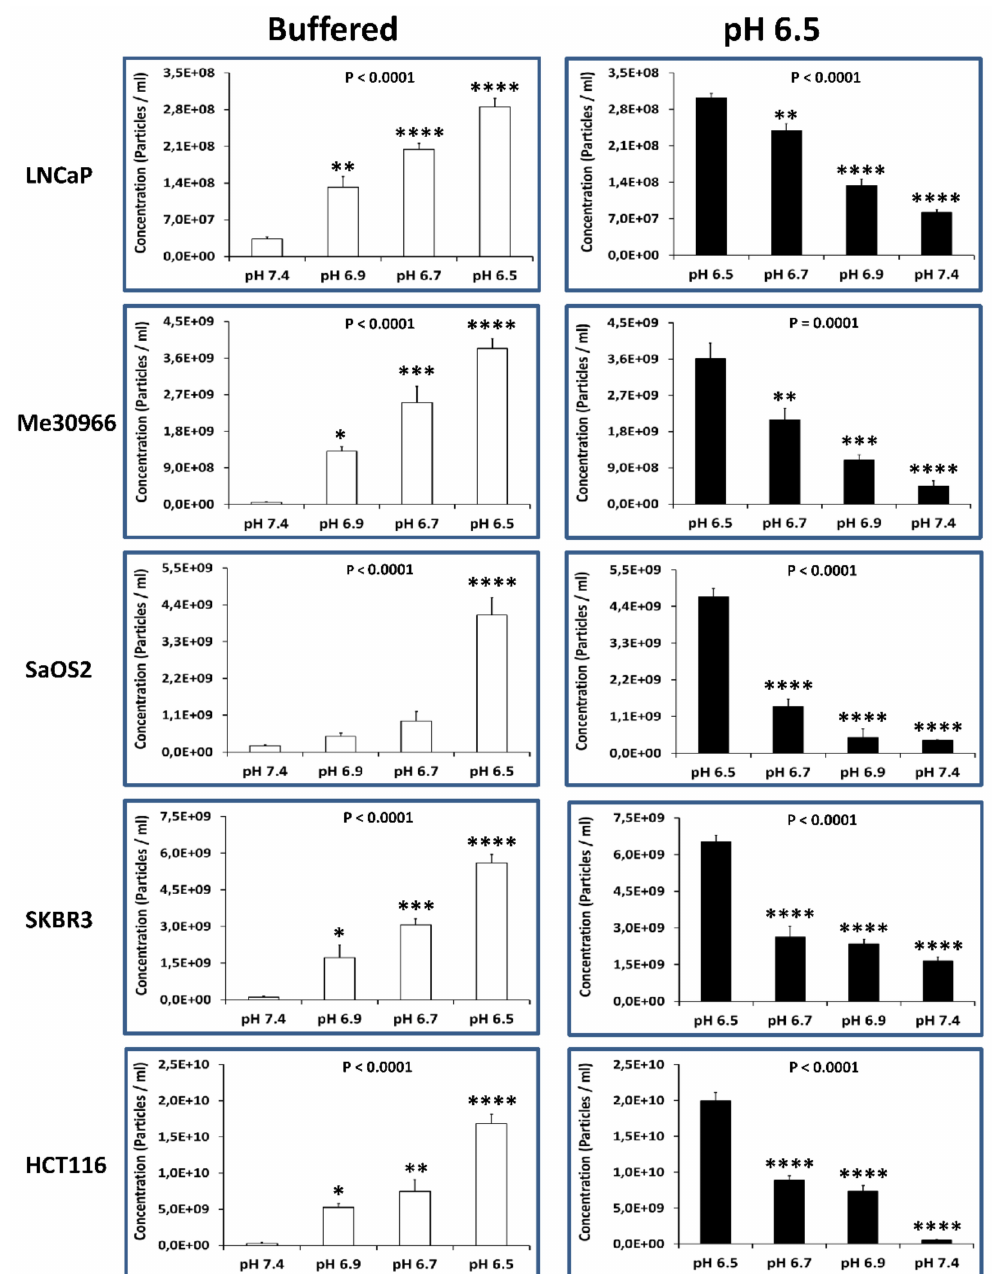
Figure 5. Alkalization of the tumor environment induces a reduction of exosome release. ( Left ) NTA analysis for the distribution and concentration of the number of exosomes released by the tumor cells cultured in pH conditions ranging from 7.4 to 6.5 (i.e., 7.4, 6.9, 6.7, and 6.5). Data are expressed as means ± SE of three independent experiments. The p -value was <0.0001 in all cellular lines cultured in acidic pH with respect to buffered conditions. ( Right ) NTA analysis for the distribution and concentration of the number of exosomes released by the tumor cells cultured in pH conditions ranging from 6.5 to 7.4 (i.e., 6.5, 6.7, 6.9, and 7.4). Data are expressed as means ± SE of three independent experiments. The p -value was ≤ 0.0001 in all cellular lines cultured in buffered conditions with respect to pH 6.5 conditions. * p < 0.1, ** p < 0.01, *** p < 0.001, **** p <